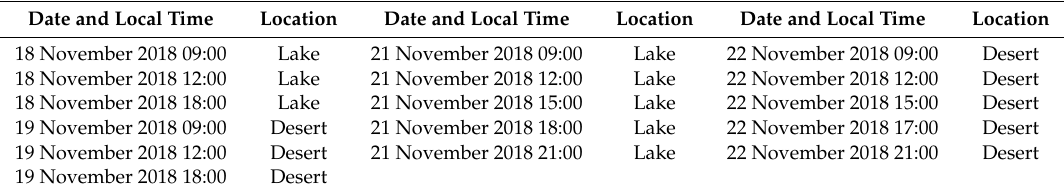
Table 3. Schedule of the radiosonde